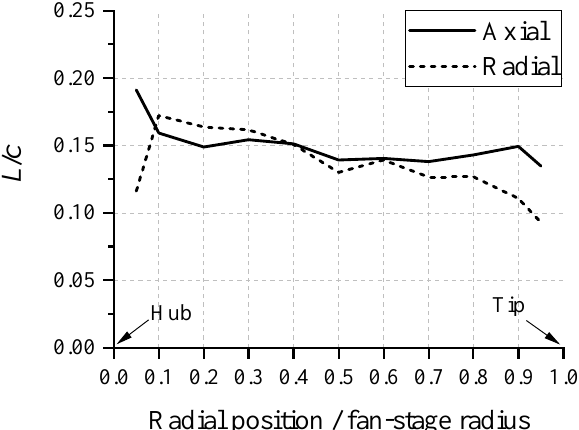
Figure 7. The axial and radial integral length scales of turbulence in the interstage for the base- line